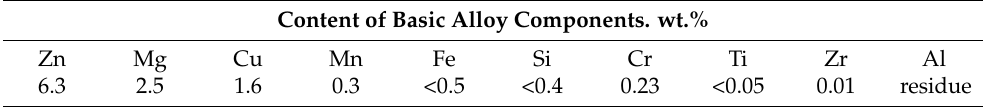
Table 1. Chemical composition of the investigated